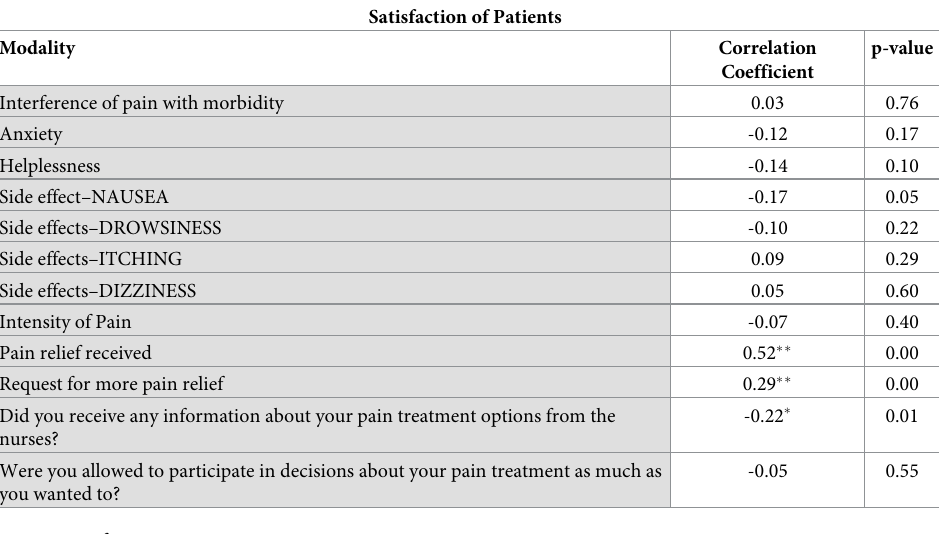
Table 4. Outcome of pain management as predictors of satisfaction in patients.